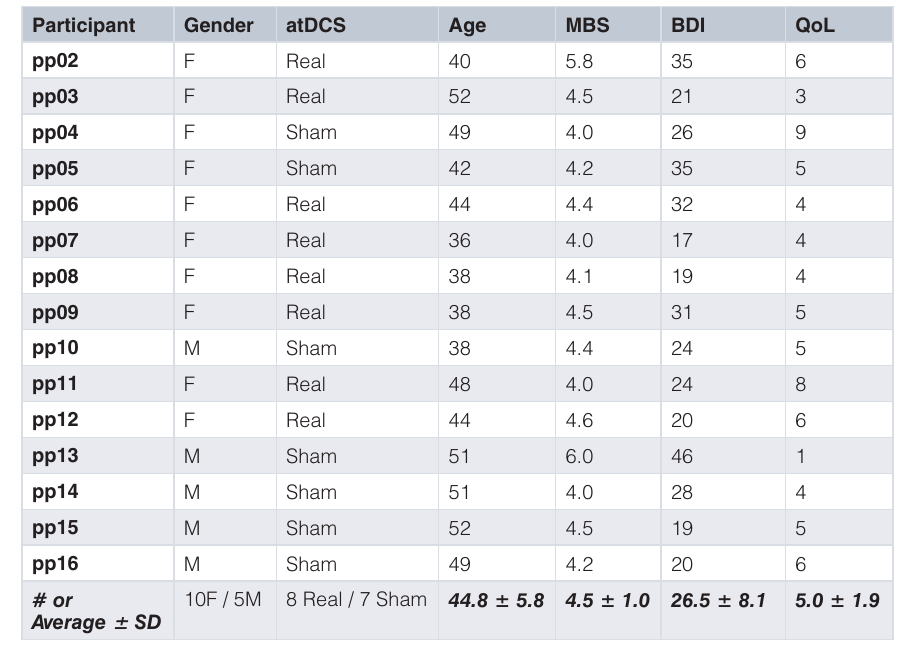
Table 2B. Demographic characteristics and working-related information. Participant Employment Education pp02